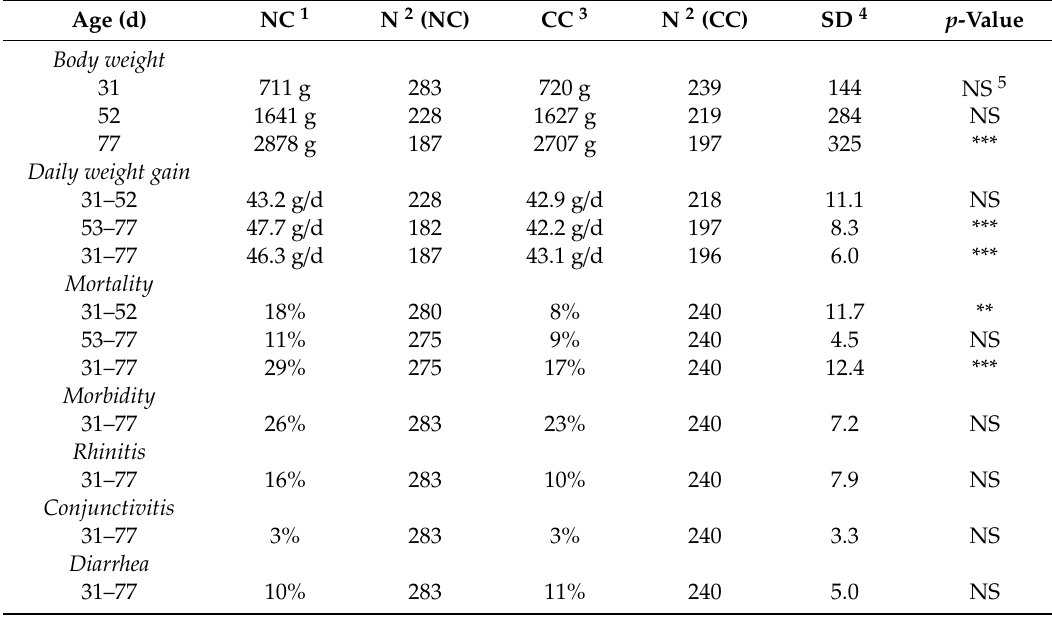
Table 2. Body weight, daily weight gain, mortality and morbidity of fattening rabbits from new and conventional housing